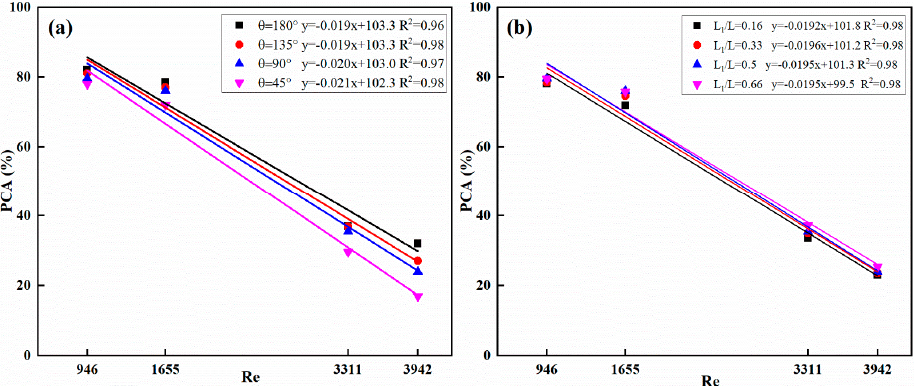
Figure 14. The correlations between Re and PCA: ( a ) The bending angle; ( b ) The distance